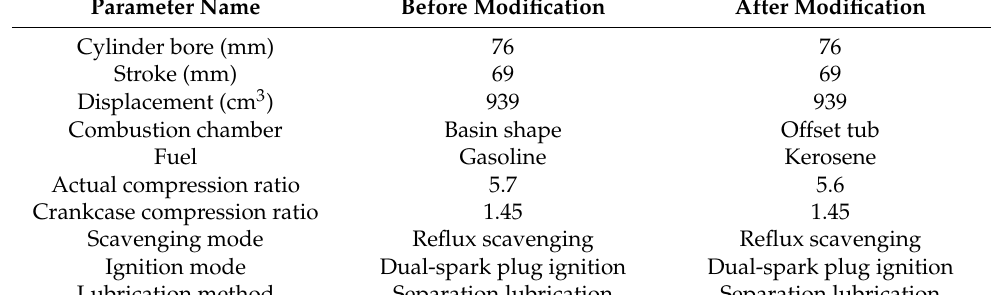
Table 3. Comparison of the main parameters of the engine before and after direct injection transfor- mation.